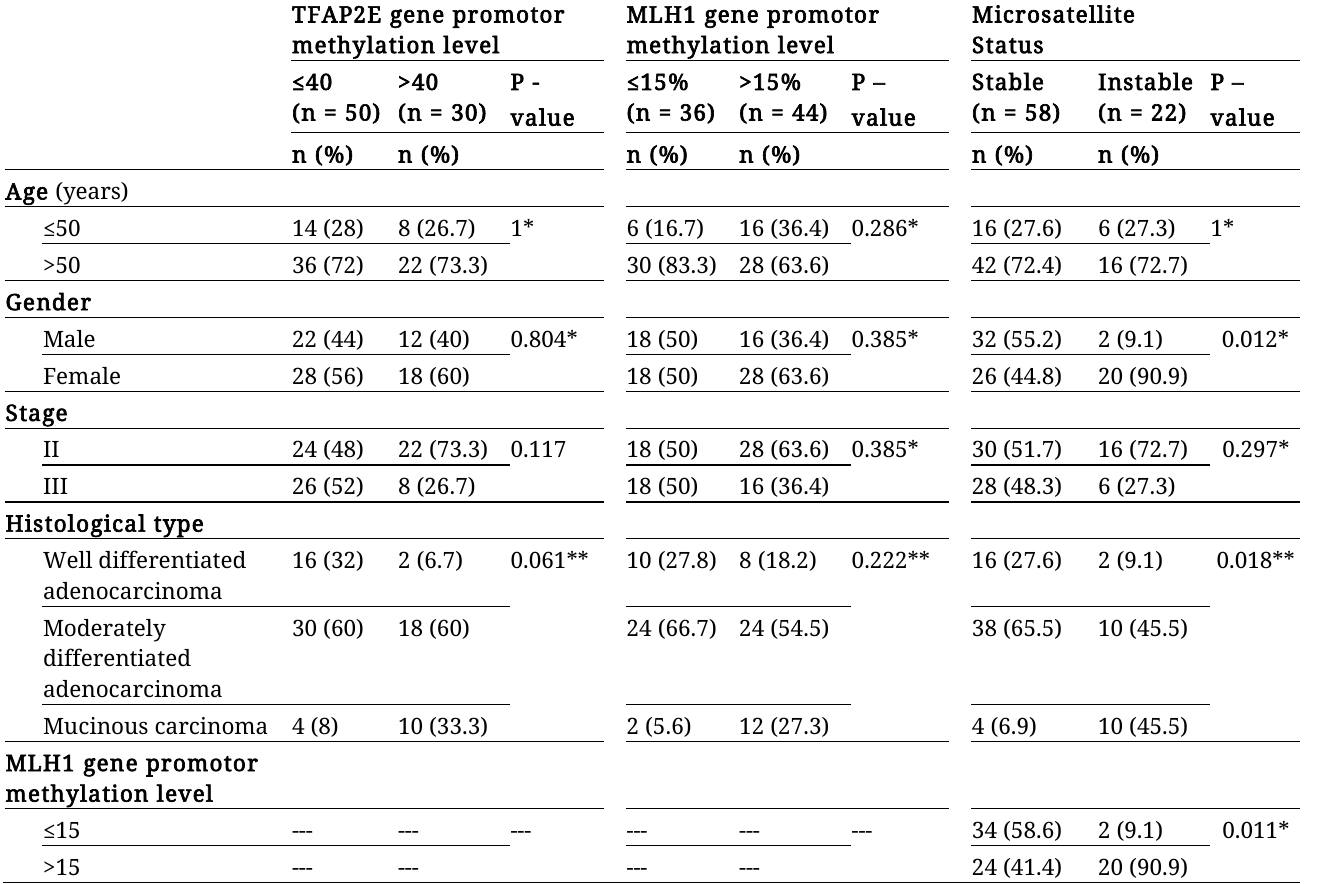
Table 2: Relation between clinico-pathological data and promotor methylation of TFAP2E and MLH1 genes and Microsatellite